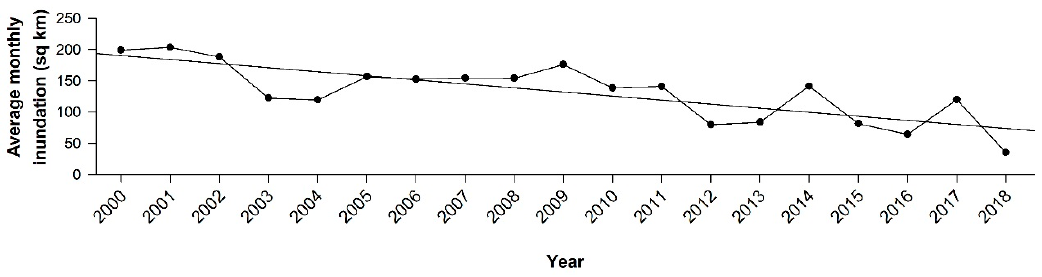
Figure 12. The reconstructed average monthly inundation area in Can Tho City from 2000 to 2018. Inundation is decreasing over time similar to that observed in other parts of the Vietnamese Mekong Delta [34] .